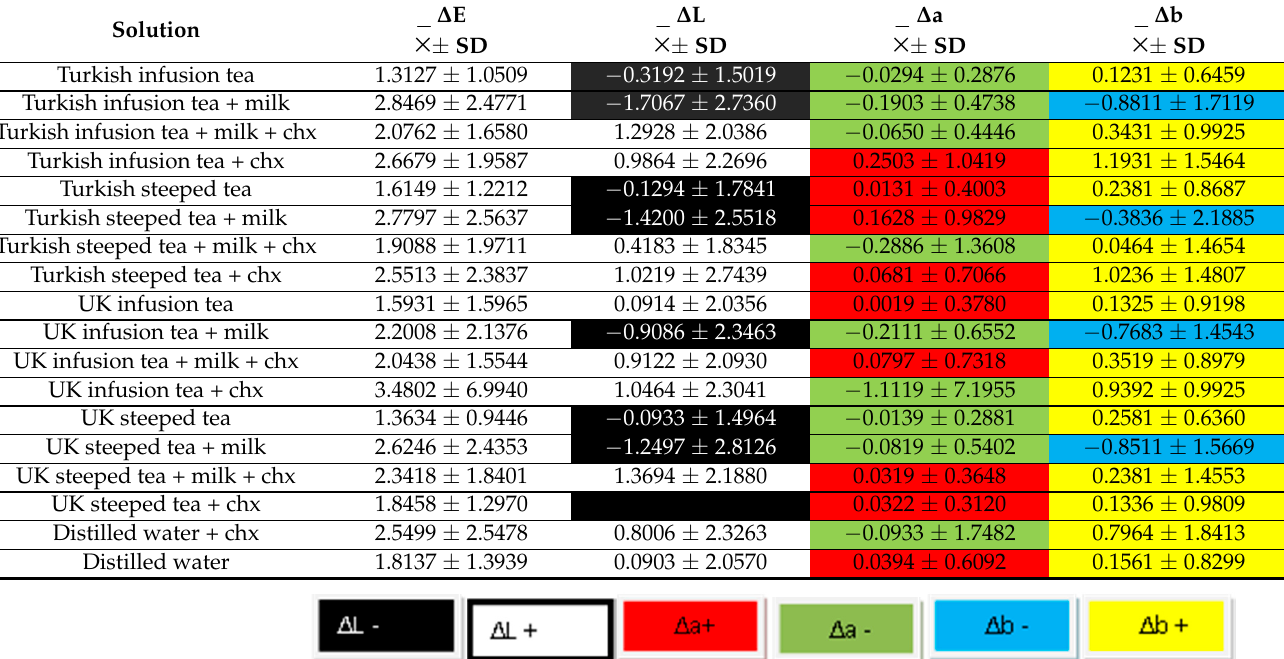
Table 1. Color changes in the dental enamel surface after application of various solutions.